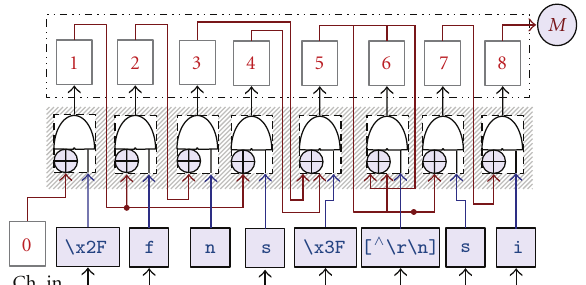
Figure 6: REM circuits constructed by mapping Figure 5 directly to HDL. The ⊕ symbols represent logic OR gates.